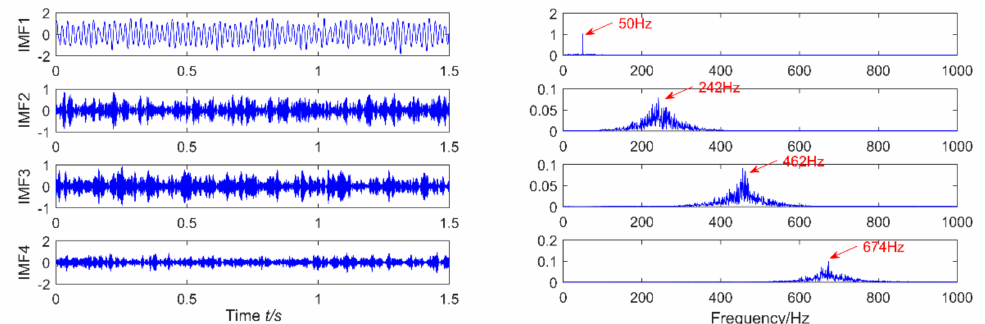
Figure 12. The simulation signal is decomposed using VMD results.